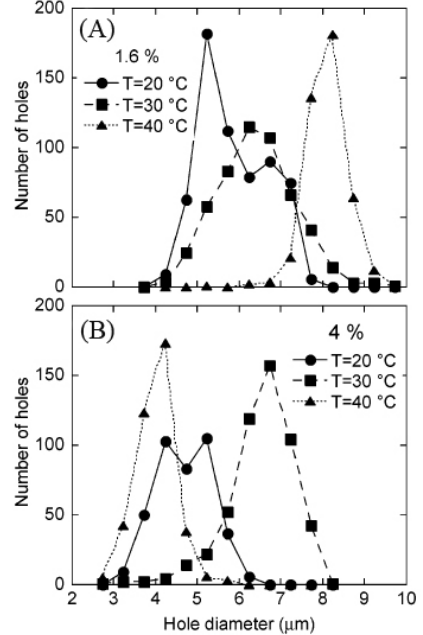
Figure 8. The pore size distribution of the PS100K-2COOH honeycomb films from CS 2 solutions at different temperatures for samples with the polymer concentration of 1.6% ( A ) and 4% ( B ), with copyright permission from